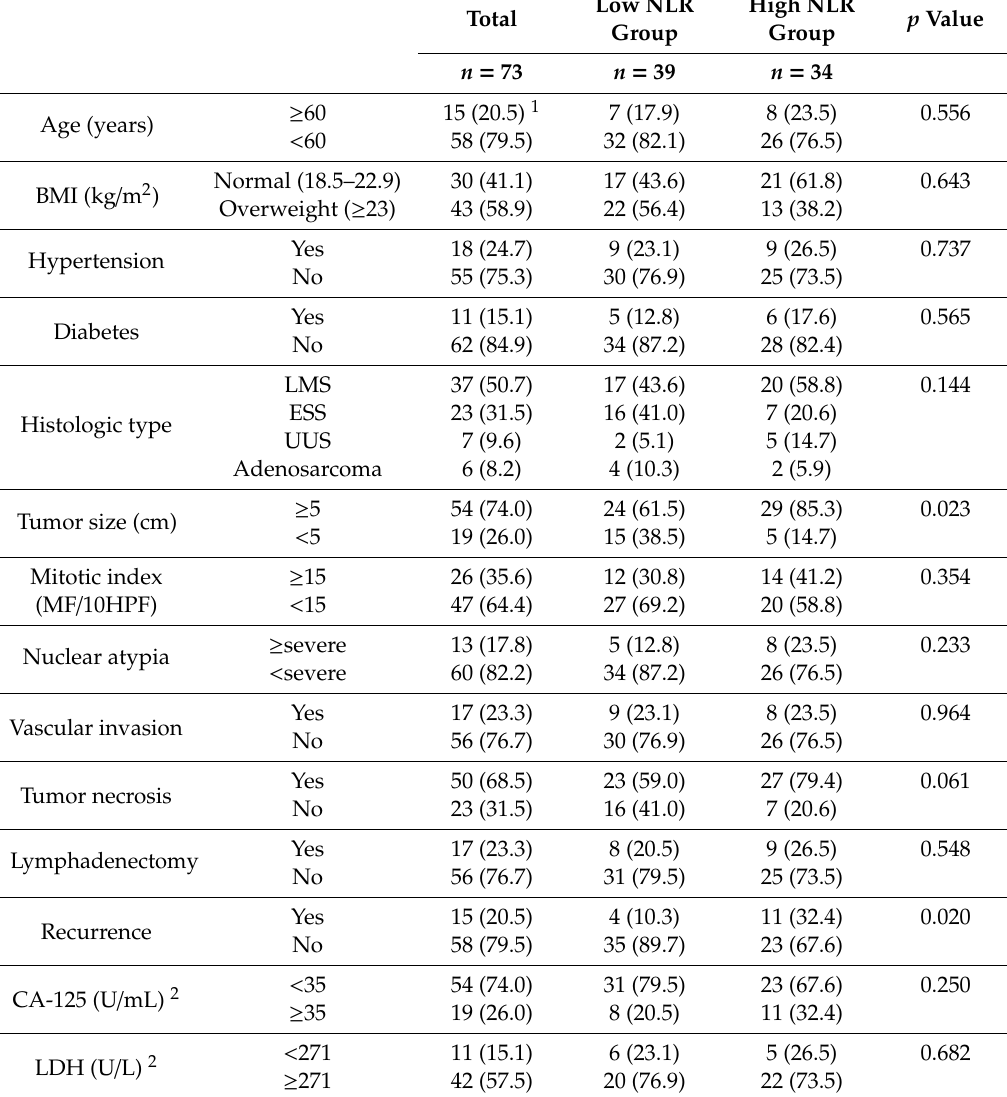
Table 4. Baseline patient characteristics in stage